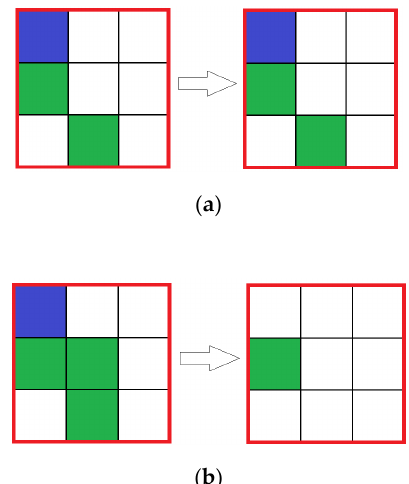
Figure 3. Reaction for di ff erent central cell states in nine cells group: ( a ) and ( b ) are time steps before Figure 3. Reaction for different central cell states in nine cells group: ( a ) and ( b ) are time steps before Figure 3. Reaction for different central cell states in nine cells group: ( a ) and ( b ) are time steps before Figure 3. Reaction for different central cell states in nine cells group: ( a ) and ( b ) are time steps before Figure 3. Reaction for different central cell states in nine cells group: ( a ) and ( b ) are time steps before Figure 3. Reaction for different central cell states in nine cells group: ( a ) and ( b ) are time steps before Figure 3. Reaction for different central cell states in nine cells group: ( a ) and ( b ) are time steps before Figure 3. Reaction for different central cell states in nine cells group: ( a ) and ( b ) are time steps before and after reaction respectively. and after reaction respectively. —Reagent and after reaction respectively. and after reaction respectively. and after reaction respectively. and after reaction respectively. and after reaction respectively. and after reaction respectively.